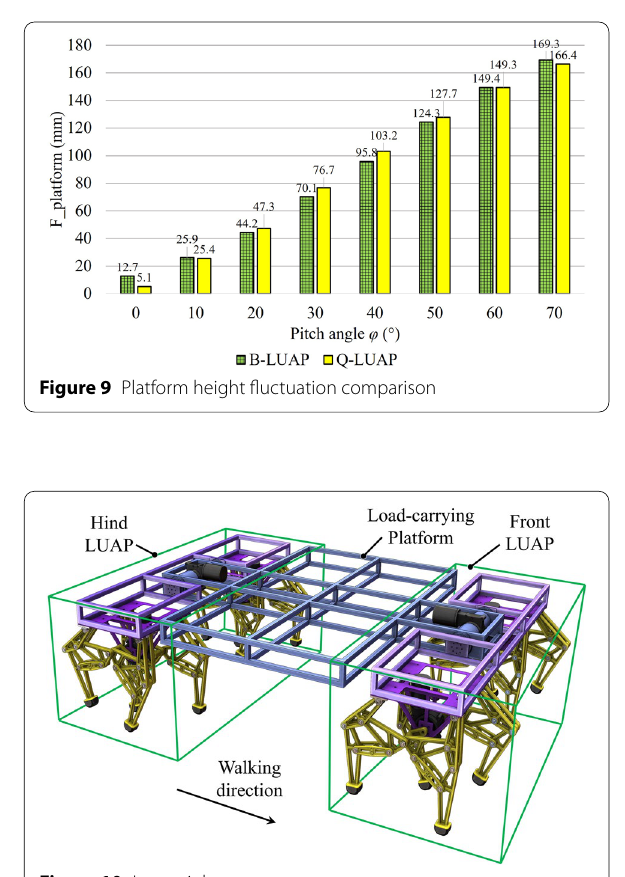
Figure 10 Leg unit